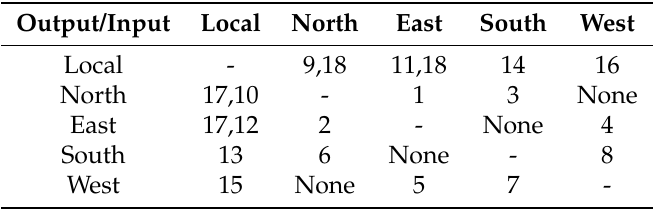
Table 1. Microring Resonators’ (MRs) configuration for data